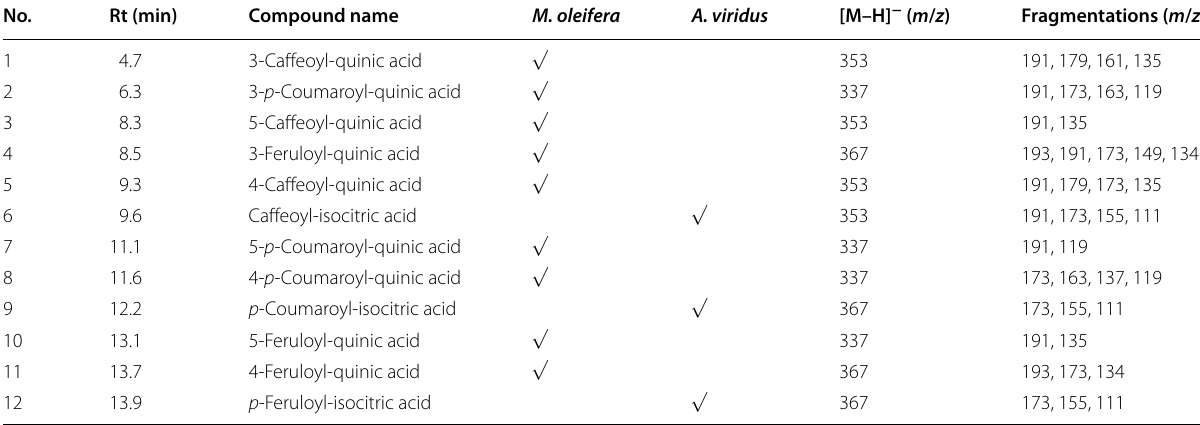
Table 1 Characterization of hydroxyl-cinnamic acid conjugates from M. oleifera and A. viridus No. Rt (min) Compound